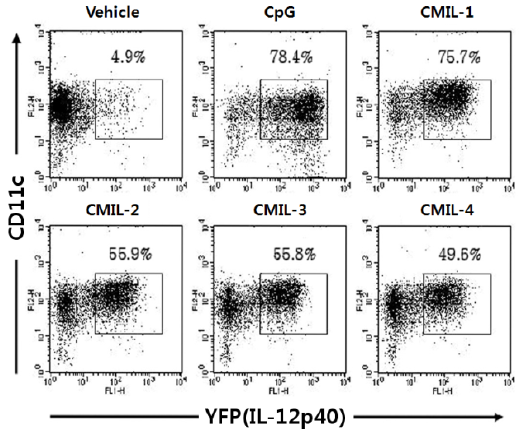
beginning at about 5 hrs after stimulation. Taken together, DCs derived from the cytokine reporter system can be utilized as biosensors for screening cytokine-inducing molecules. Figure 7. Identification of four bio-compounds inducing IL-12 p40 expression via the cytokine reporter system. Flt3L-cultured BMDCs were stimulated with vehicle, CpG (5 μ g/ml), CMIL-1, -2, -3 or -4. Sixteen hours later, IL-12 p40 expression was analyzed by flow cytometry for YFP expression Reprinted from Ref [64] with permission from The Korean Society for Molecular and Cellular Biology.